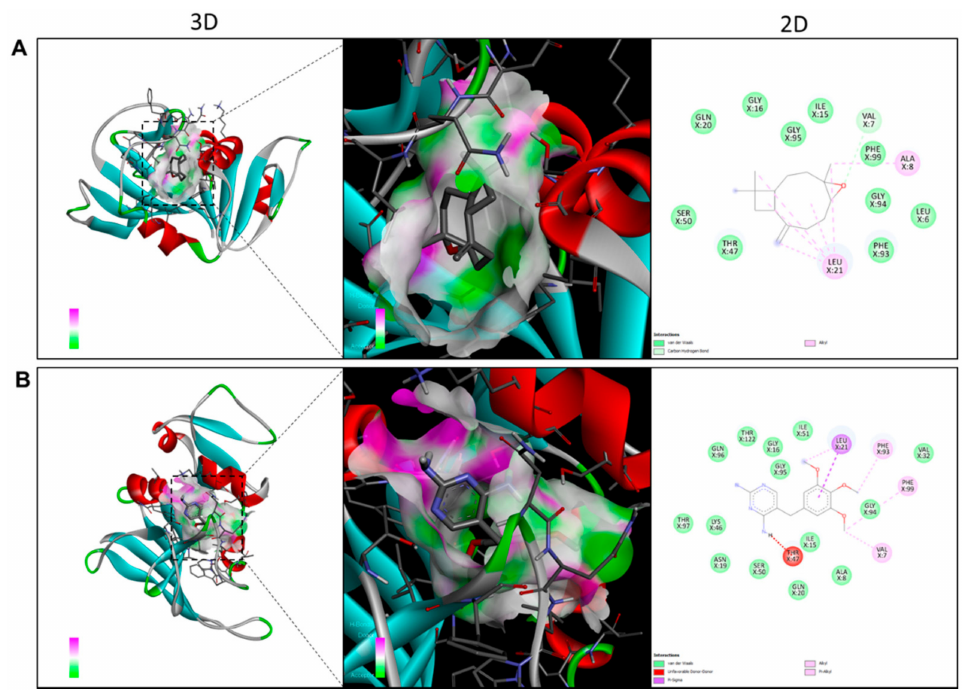
Figure 6. 2D and 3D diagrams illustrating the binding patterns of the ( A ) caryophyllene oxide, and ( B ) trimethoprim into the active site of Dihydrofolate Reductase (PDB ID- 3SRW) showing H-bond donor (pink) and acceptor (green) surfaces in the docked